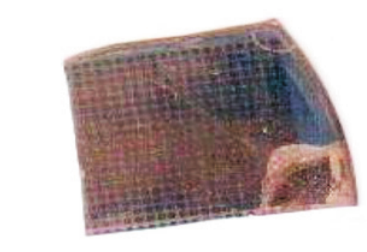
Fig. 5. PZT sample prepared in lab